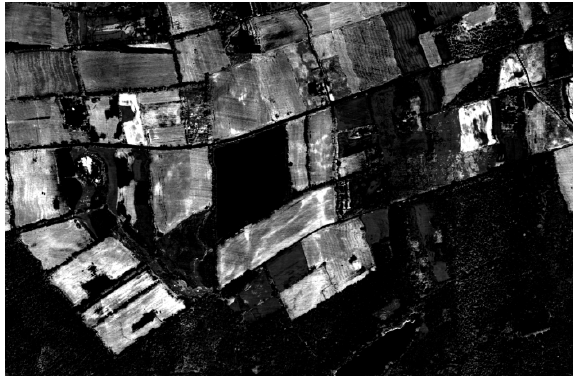
Figure 9. Endmember 8 abundance map. The brighter the pixel, the higher is the percentage of the eighth endmember (agricultural crops) in the image.